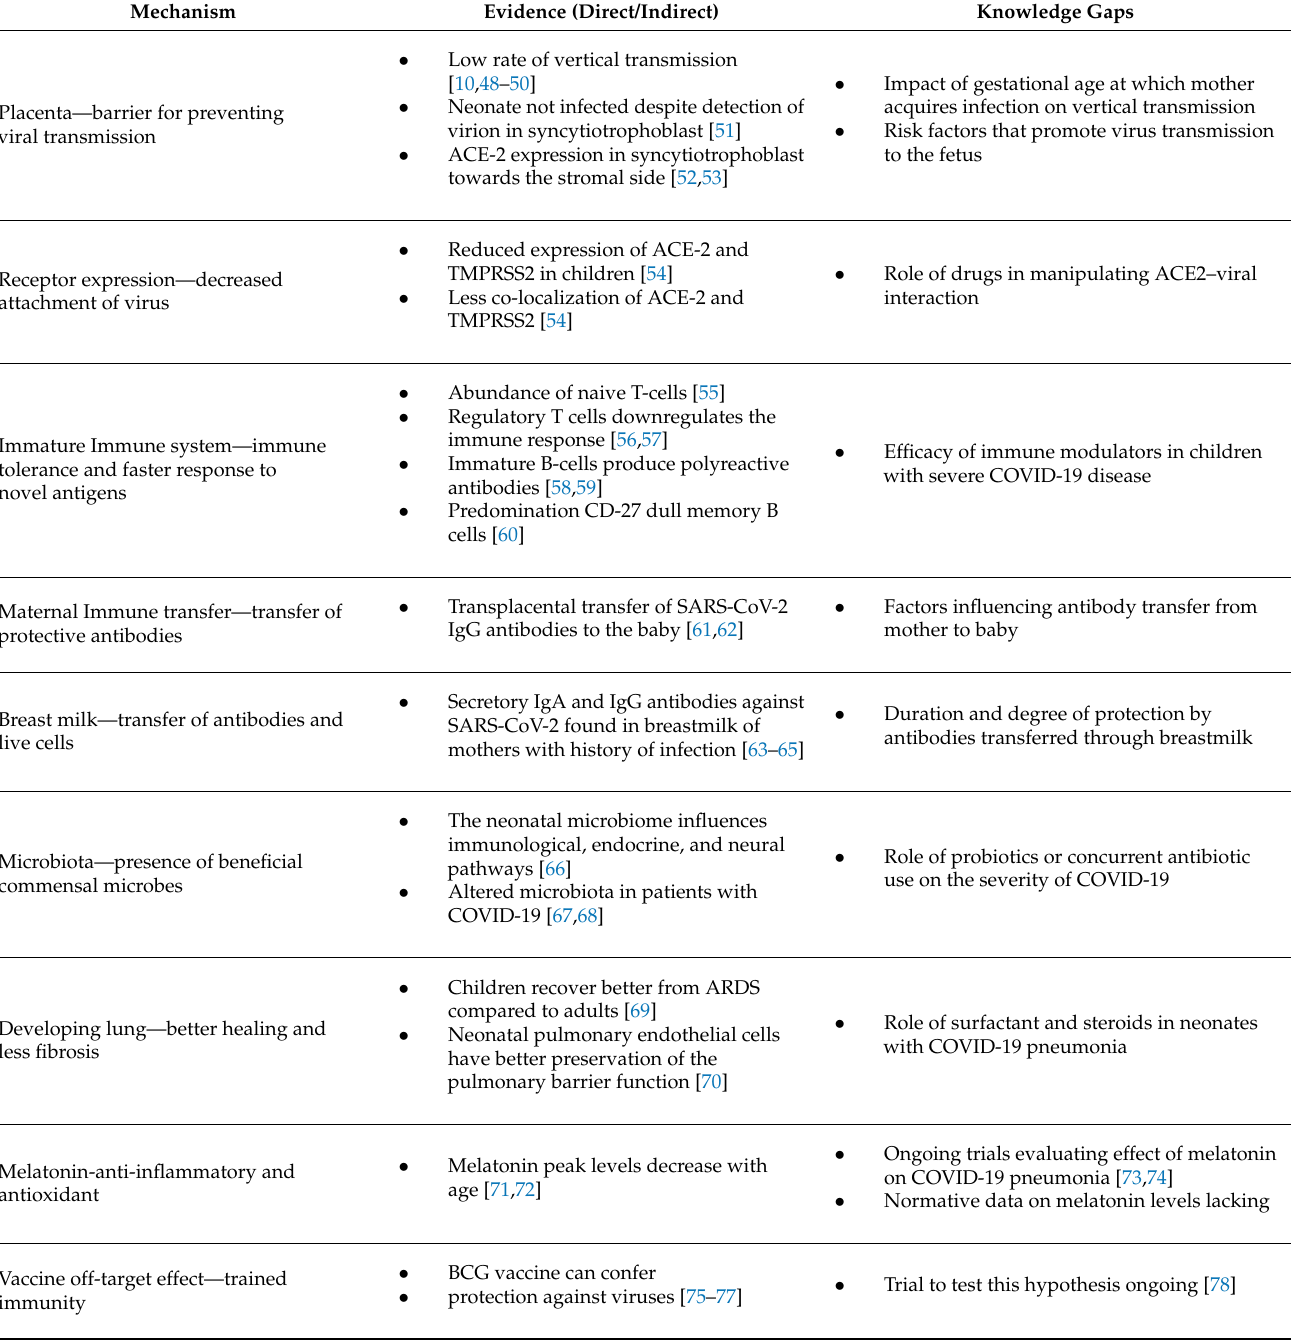
Table 1. Evidence and knowledge gaps regarding various proposed mechanisms protecting neonates from COVID-19